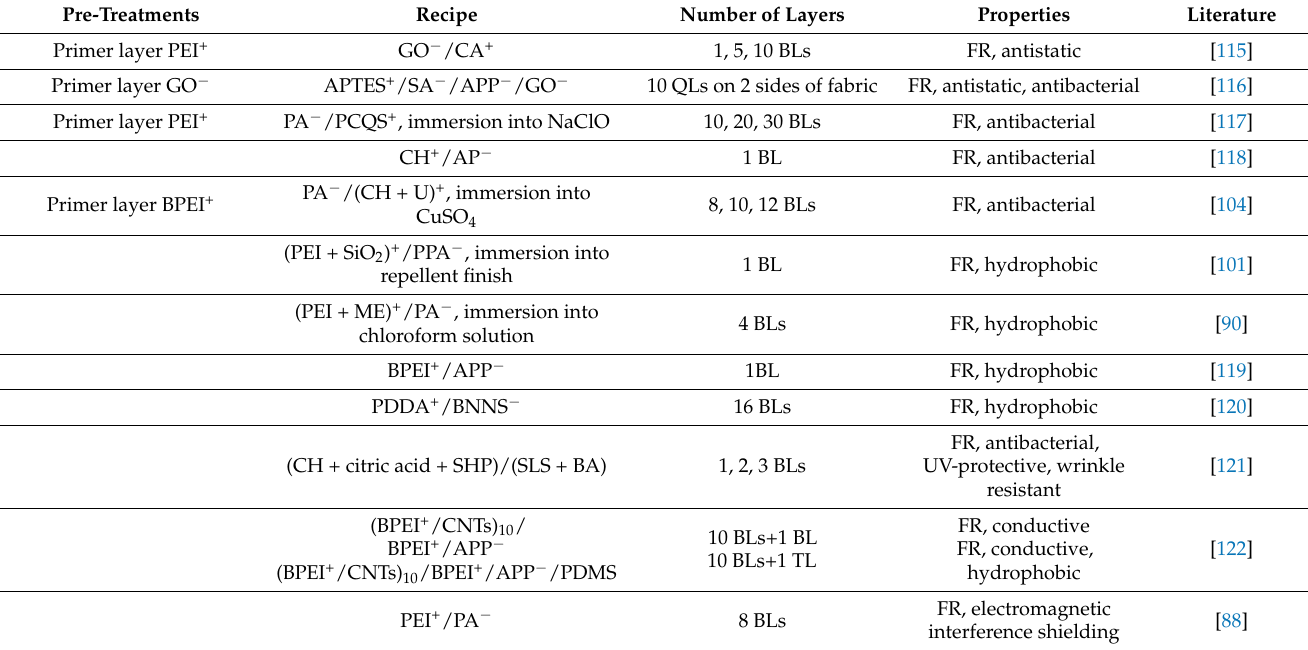
Table 2. Polyelectrolytes used to achieve FR and other multifunctional properties of cotton.